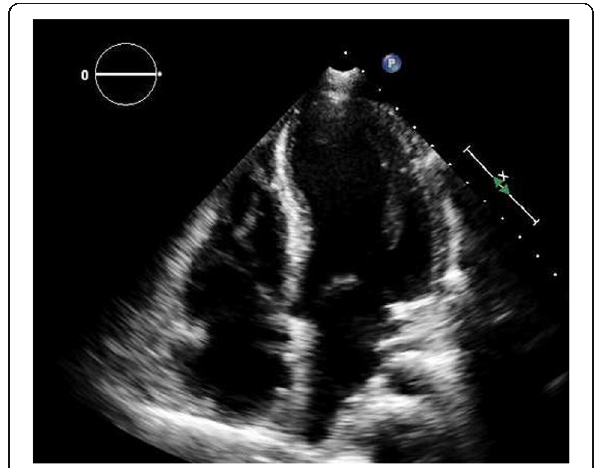
Fig. 6 Post-operative transthoracic two-dimensional echocardiography, apical 4-chamber view showing no intra-cardiac